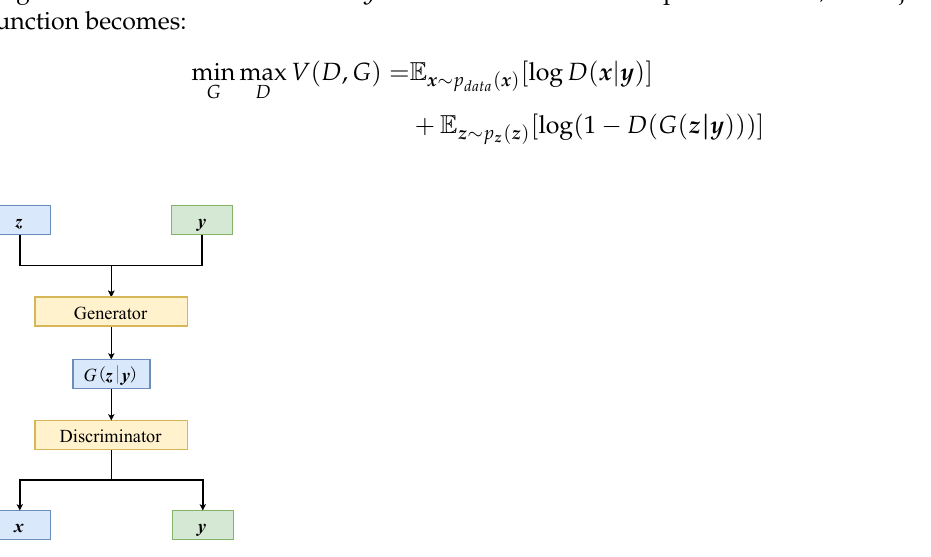
Figure 1. The generic framework of GAN. Compared with GAN, it also takes the condition y as the input of the generator and